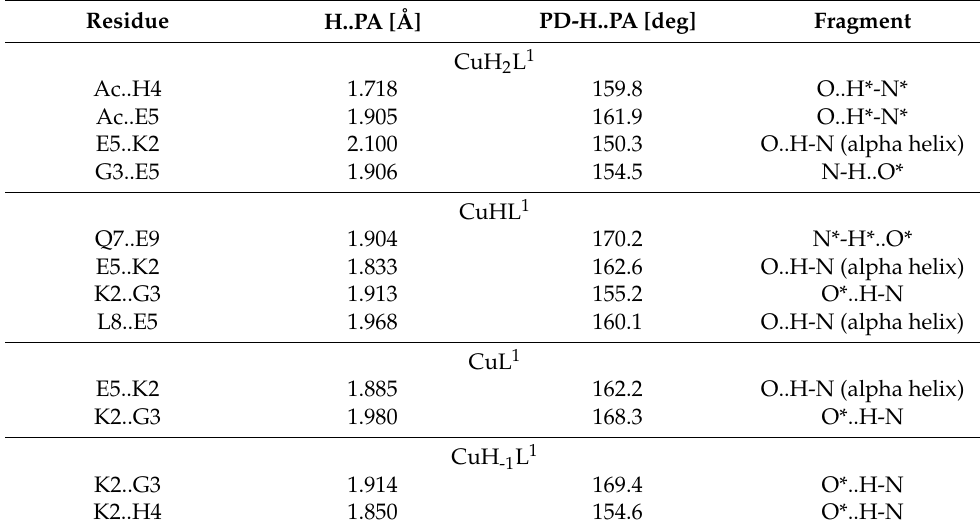
Figure 4. The competition plot for Cu(II), Ac-AKGHEHQLE-NH 2 , Ac-FGEHEHGRD-NH 2 , Ac- KEHK-NH 2 and Ac-EHKA-NH 2 with M/L molar ratio of 1:1, [Cu(II)] = 1 mM. Table 3. Hydrogen bonds of Cu(II)-L 1